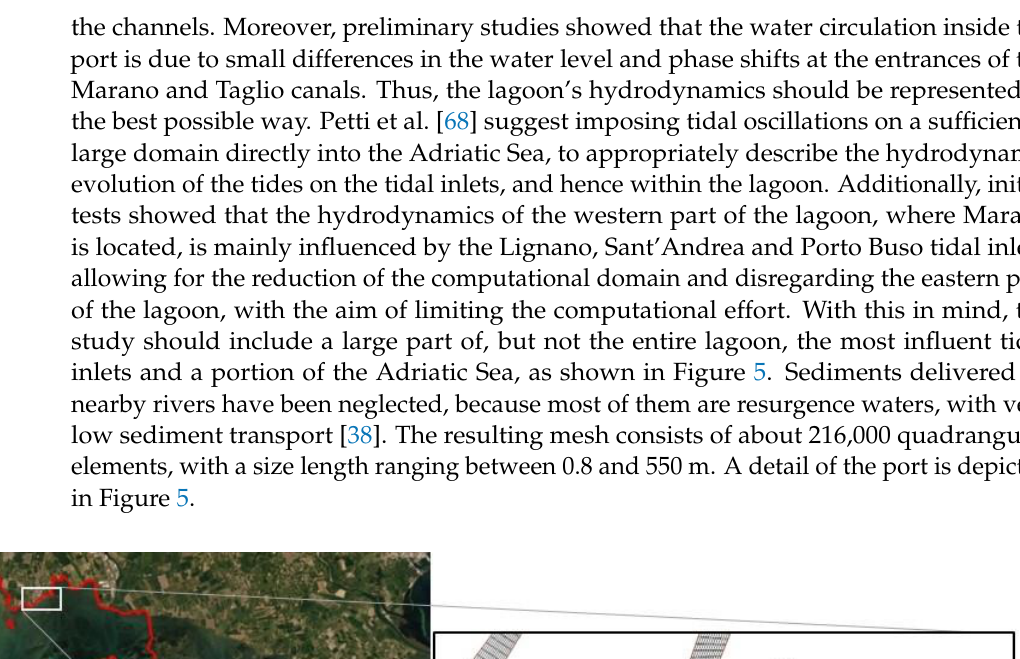
Figure 6. Comparison of measured (dashed lines) and computed (solid lines) water levels at the stations of Marano (red) and Lignano (black) in the period from 18 to 21 September 2014. Root-mean square errors over the entire simulation are evaluated as 0.018 m for Lignano data and 0.033 m for Marano data.